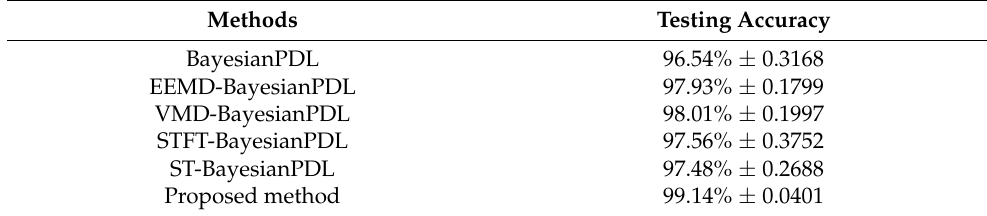
Table 3. Test results using different data preprocessing